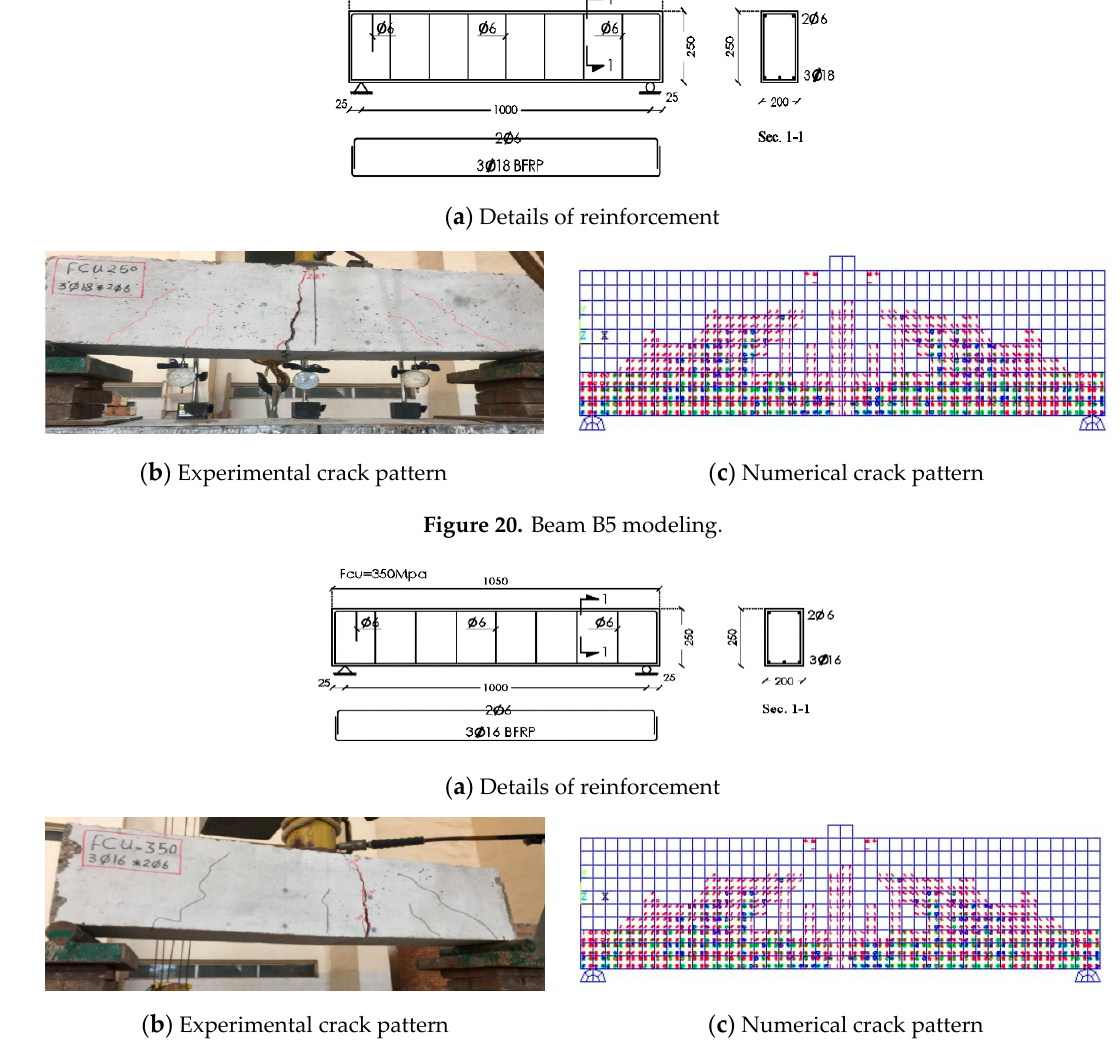
Figure 21. Beam B6 modeling.